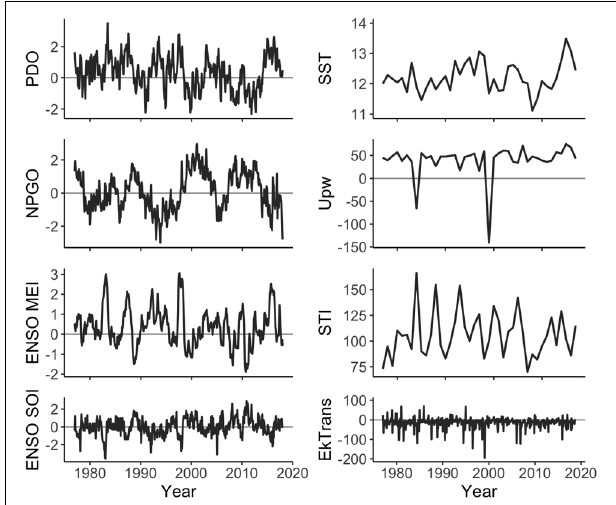
FIGURE 2 | Ocean conditions measurements from 1977 to 2017. Regional factors (PDO, ENSO SOI, ENSO MEI, and NPGO) are monthly index values. Local factors (EkTrans, SST, Upw, and STI) are shown, for example, at 45 ◦ N. Northward EkTrans (value × 10 = metric tons second − 1 kilometer − 1 ) are shown as monthly values. SST ( ◦ C), Upw (meters 3 second − 1 per 100 m of coastline), and STI (day of year) are annual